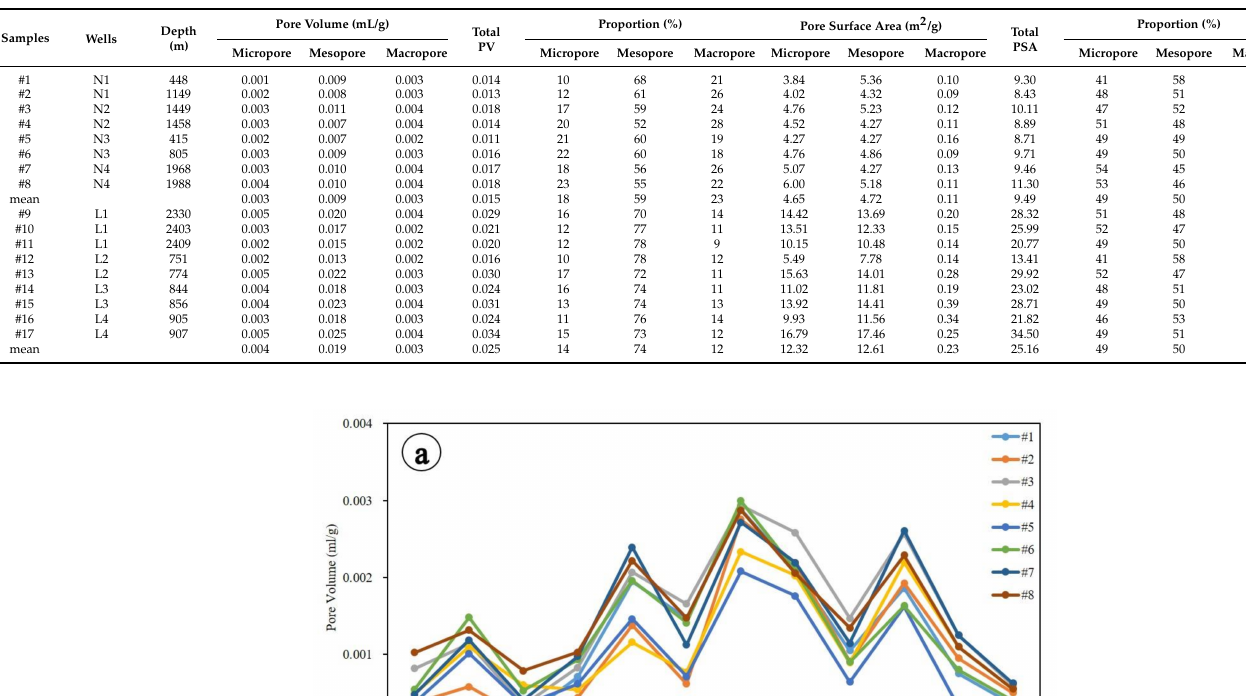
Table 2. The PVs, surface areas, and the corresponding proportions of Lower Cambrian shale and Lower Silurian shale analyzed by N 2 adsorption experiments.